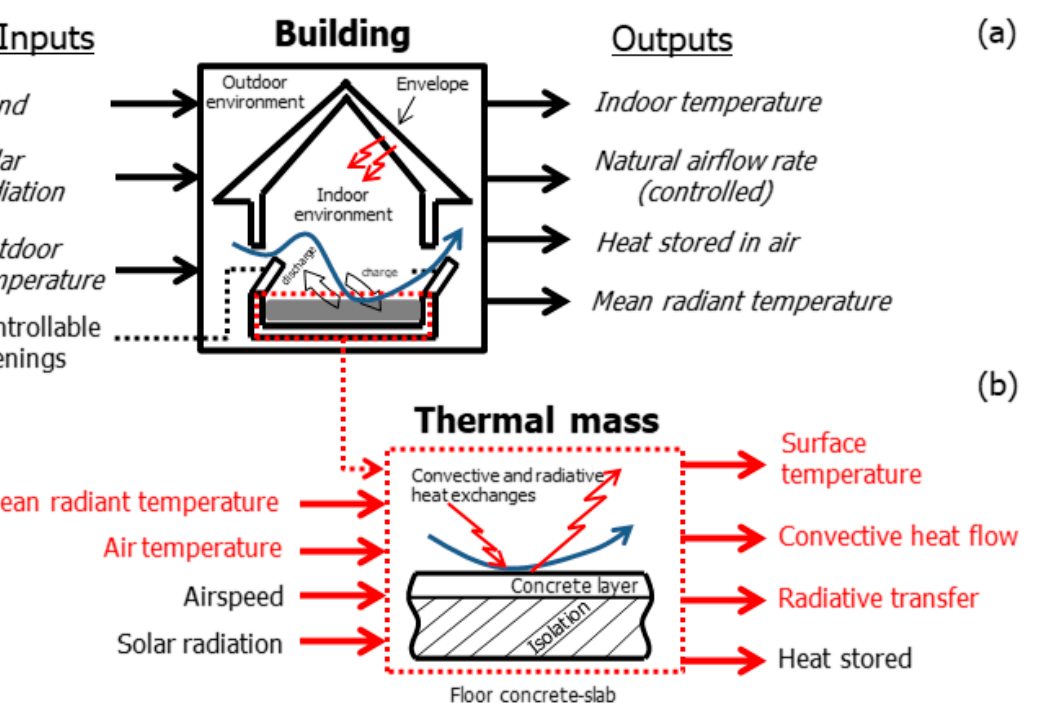
Figure 3. Domains and variables for the experimental approach: ( a ) inputs and outputs studied regarding the building domain (in italic style); ( b ) inputs and outputs studied regarding the thermal mass domain (in red).